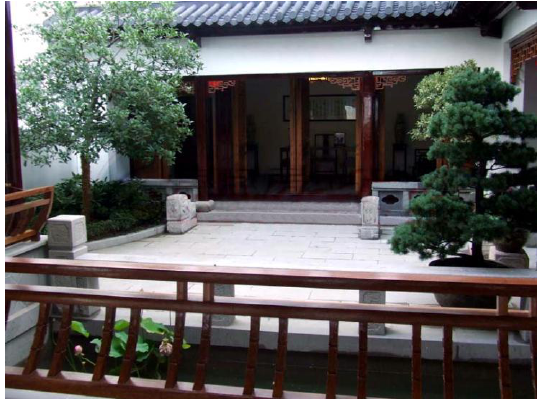
Figure 23. Courtyard with veranda in its vernacular style at Suzhou Fuyuan villa estate. Source: Suzhou Guardian Real Estate Development Co. 2007.